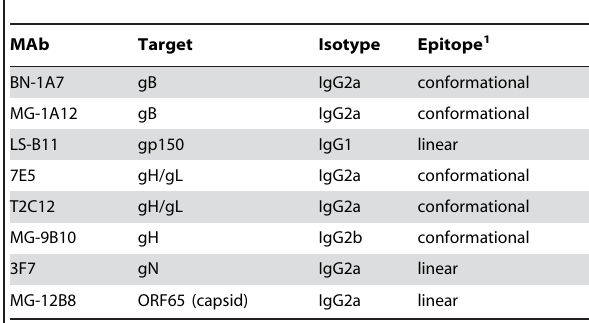
Table 2. MAbs used in this